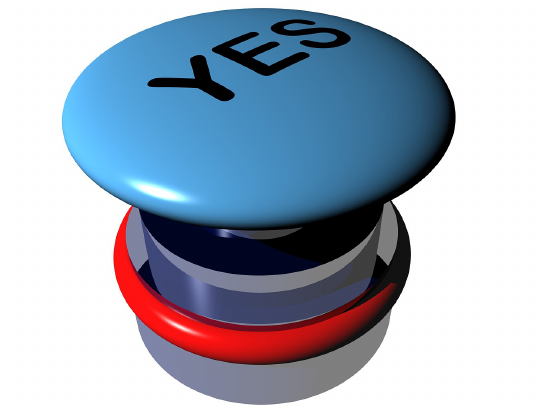
Figure 2. 3D virtual button example. Image owned by needpix.com and is under CC0 Creative Commons